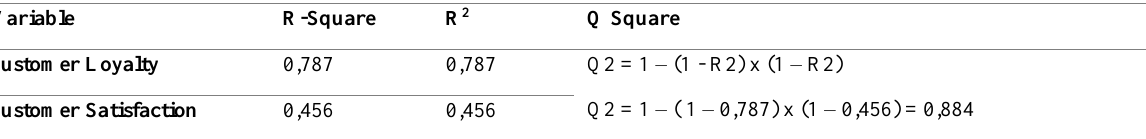
Table 4: Results of the Coefficient of Determination